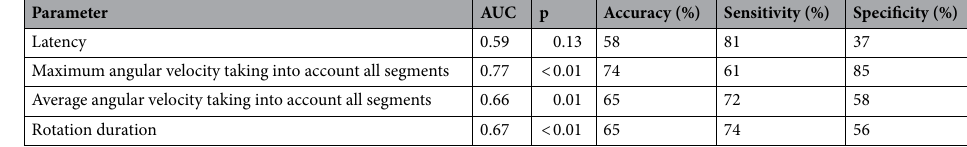
Table 3. Six-sensor model results based on ROC